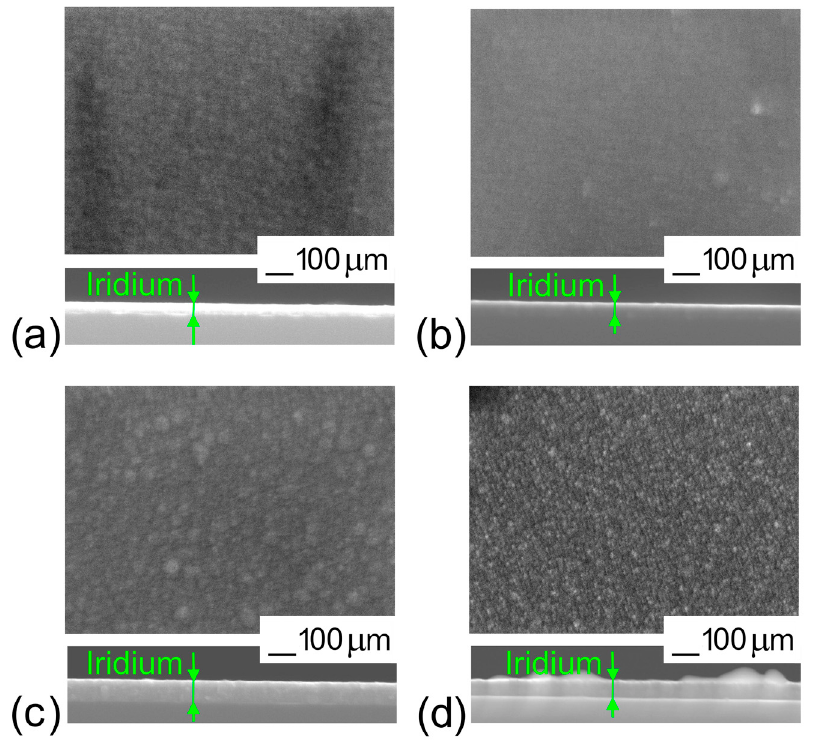
Figure 2. SEM micrographs of the surfaces and cross-sections of iridium films on Si(100) substrates: ( a ) Sample 1; ( b ) Sample 2; ( c ) Sample 3; ( d ) Sample 4. Magnification 100,000 times.